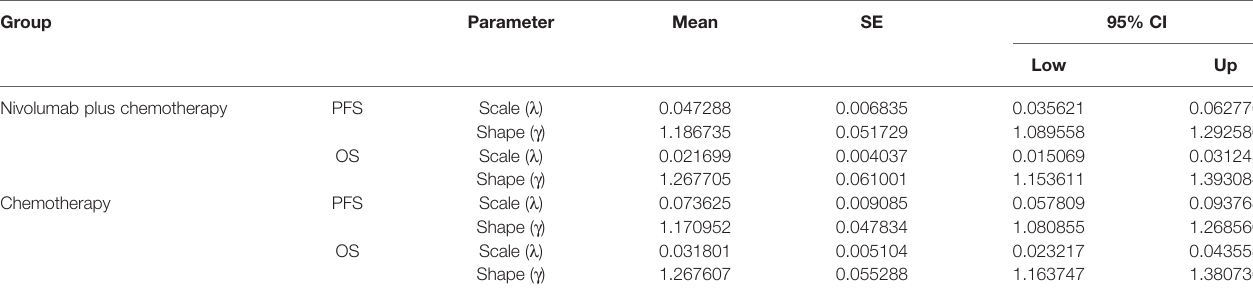
TABLE 1 | Weibull parameters of model estimated for progression-free and overall survival